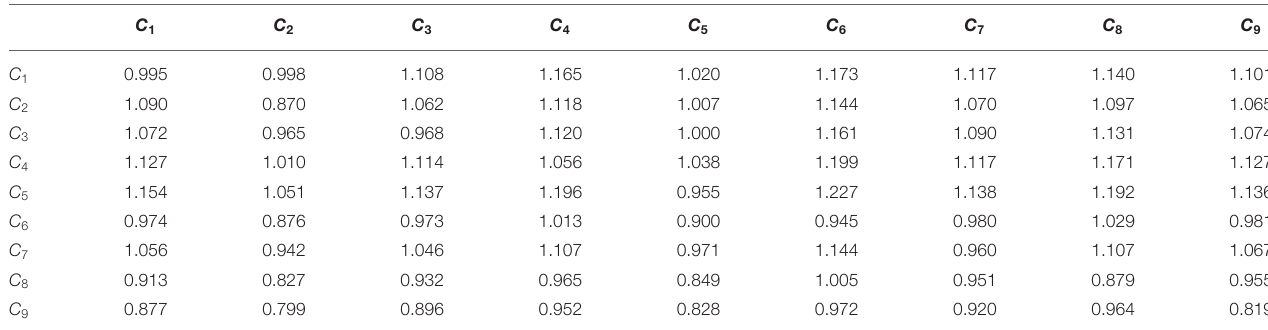
TABLE 4 | The total influence